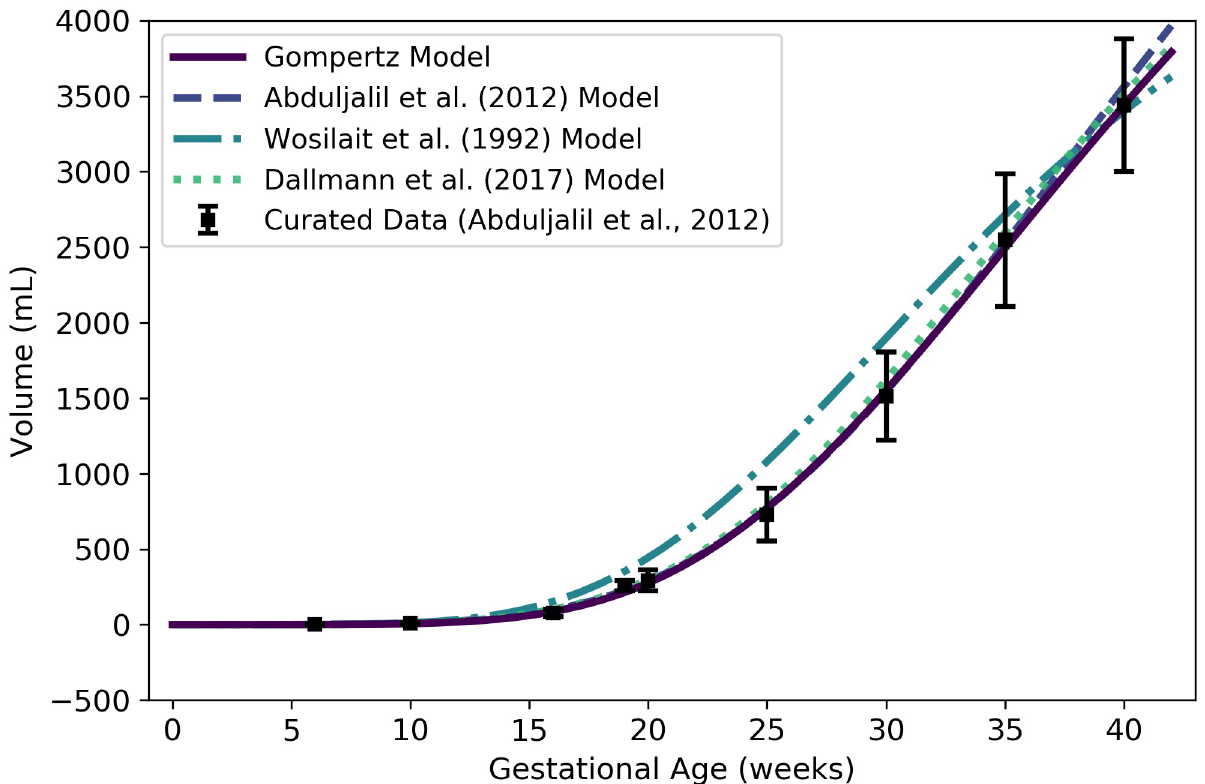
Fig 2. Volume (mL) or mass (g) of a human fetus vs. gestational age. The Gompertz model (solid line) given by Eq 2 was selected as the most parsimonious model in our analysis. The models of Abduljalil et al. [28] and Wosilait et al. [27] were also Gompertz models, though the model parameters used by those authors were different. Dallmann et al. [3] used a log-logistic model for fetal volume. The model of Abduljalil et al. [28] was calibrated using the same curated data set [28] used by us, while the models of Wosilait et al. [27] and Dallmann et al. [3] were calibrated using different data